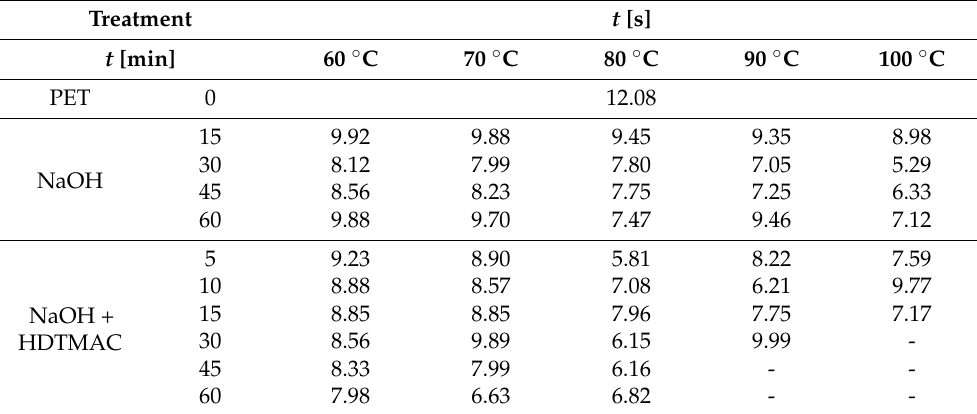
Table 3. Absorbency of PET fabrics before and after hydrolysis at temperatures 60 to 100 ◦